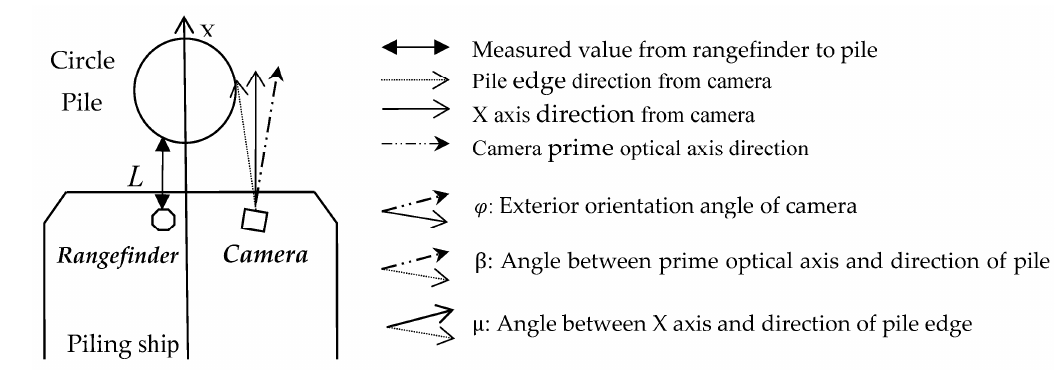
Figure 4. Direction and angle associated with CCD camera.